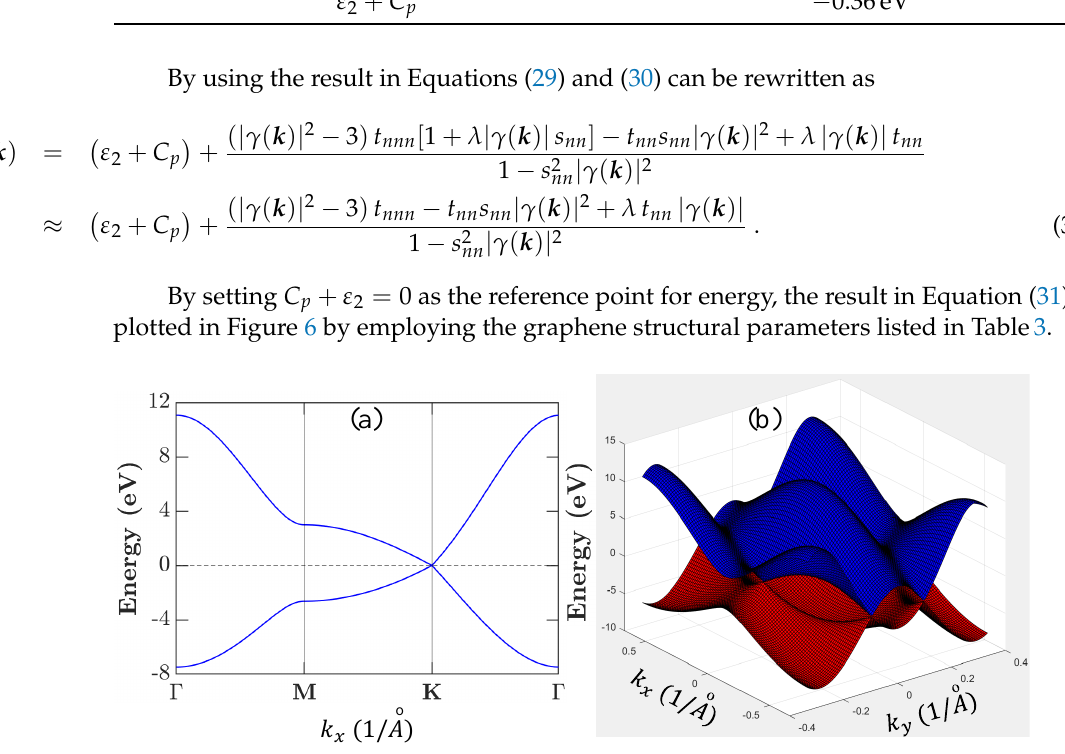
Figure 6. Calculated dispersion of energy bands for graphene. Panel ( a ) displays 2D plot for energy dispersion of graphene electrons. Panel ( b ) shows 3D plot for upper and lower bands touched at six Dirac points (three K and three K (cid:48) valleys), at which the energy is set to be